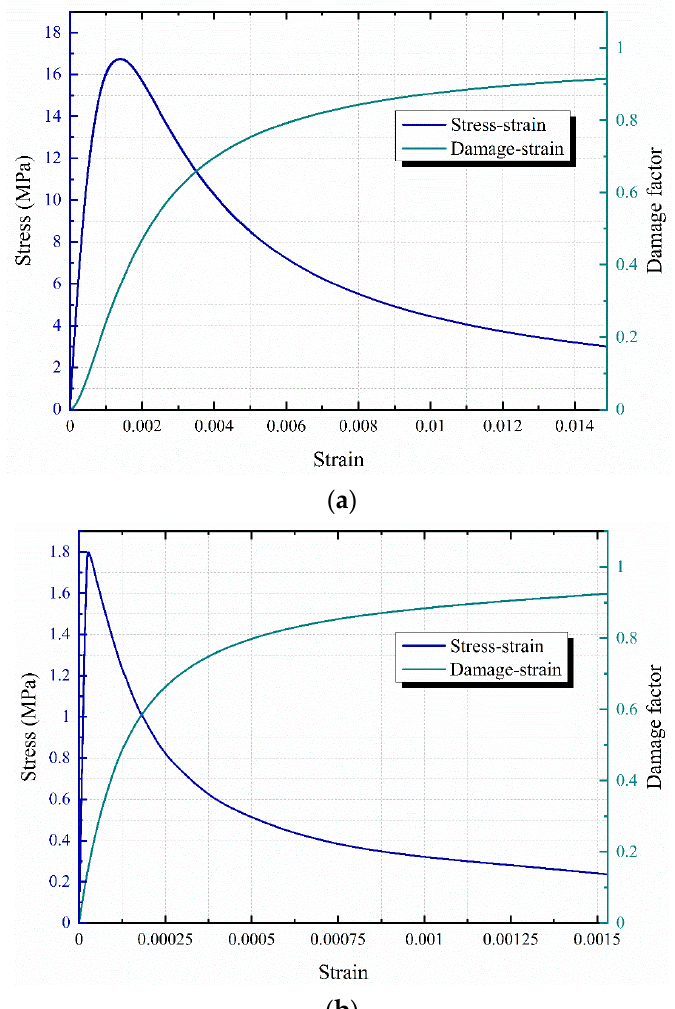
Figure 5. Damage factor and stress-strain constitutive relationships for the CPM [36] (( a ) compressive stress-strain-damage factor, ( b ) tensile stress-strain-damage factor). During strong earthquakes, the adjoining rock and the lining will inevitably interact.